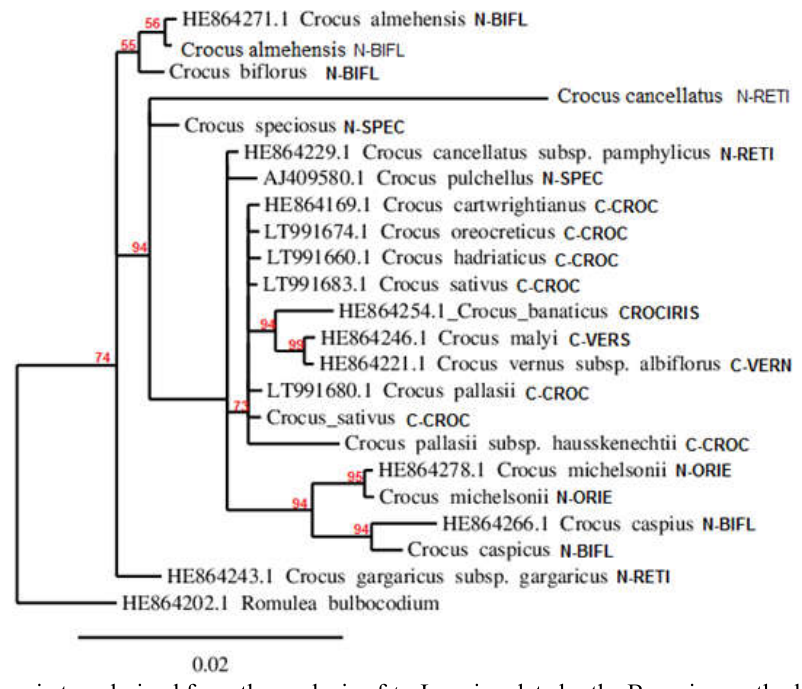
Fig. 4. The phylogenic tree derived from the analysis of trn L region data by the Bayesian method, the number above each branch shows the bootstrap